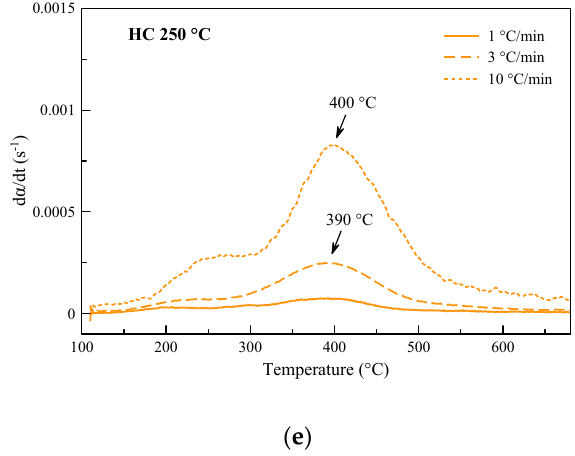
Figure 2. Derivative thermogravimetric (DTGA) curves: ( a ) during pyrolysis at 10 °C/min; ( b ) during oxidation at 10 °C/min; ( c ) effect of the heating rate during pyrolysis of hydrochar 180 °C; ( d ) effect of the heating rate during pyrolysis of hydrochar 220 °C; ( e ) effect of the heating rate during pyrolysis of hydrochar 250 °C. HC: hydrochars, d α /dt: derivative conversion curve of the extent of conversion α with respect to time t. Table 3. DTGA peak temperature and decomposition rate of pyrolysis and oxidation (10 °C/min).